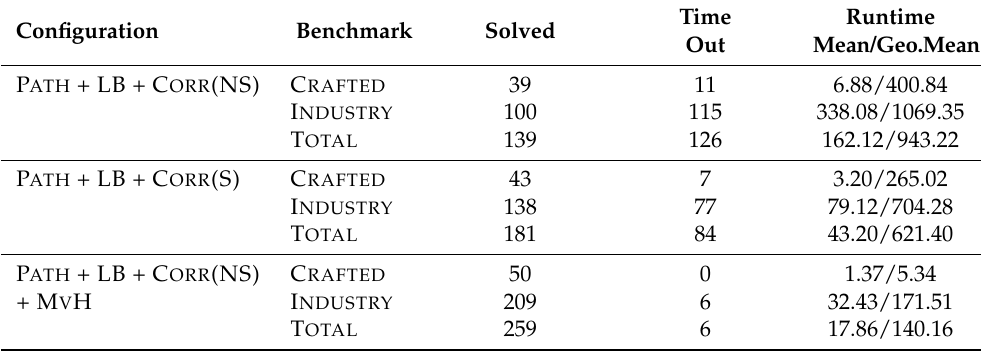
Table 5. Comparison of path encoding variants with/without basic move heuristic and differing in move corridor types and task/move acyclicity checks. Note, all problem instances grounded successfully so we only report on whether the problem was solvable or whether it timed